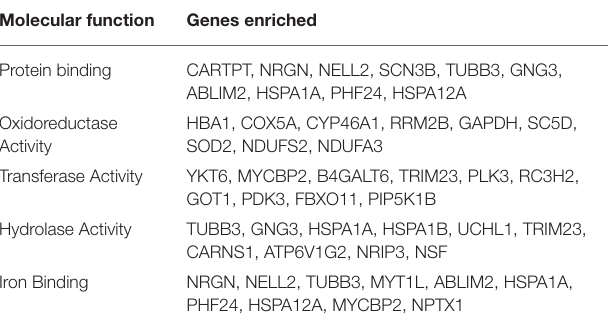
TABLE 8 | The GO molecular function enriched in the DEGs in all the comparison groups. Molecular